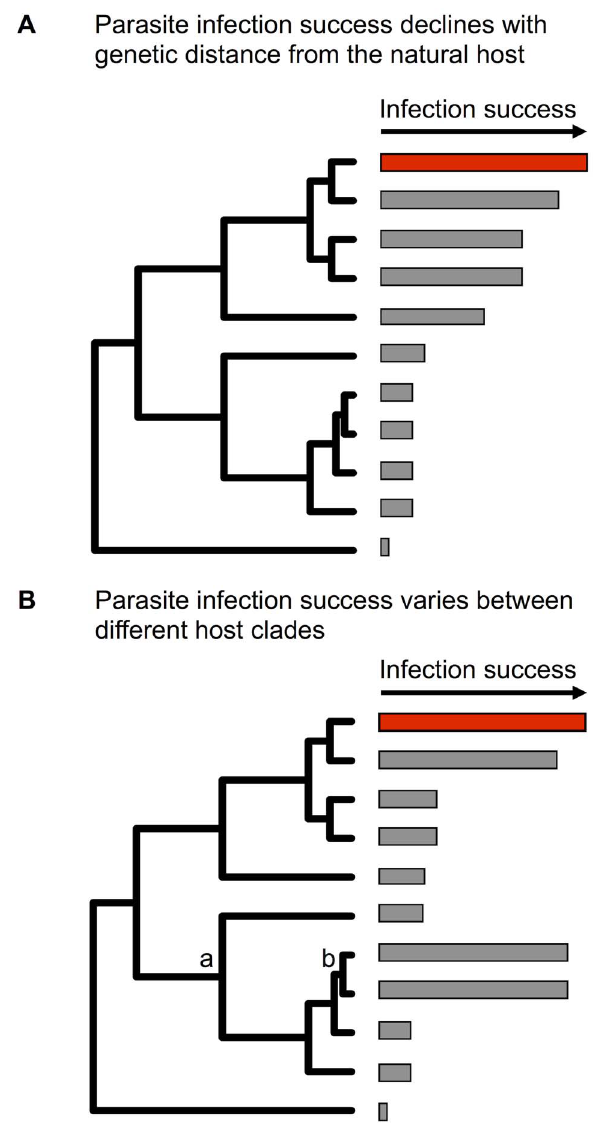
Figure 1. Two ways in which host relatedness may effect a pathogen’s ability to host shift. The bars at the tips of the trees show a measure of pathogen infection success, with the bar in red representing the pathogen’s natural host species. (A) The pathogen is less successful in host clades more distantly related to its natural host. (B) ‘‘Patches’’ of highly susceptible—or highly resistant—clades of hosts, may be scattered across the host phylogeny independently from their distance from the natural host. All of the species in the clade labelled ‘‘a’’ are equally distantly related from the pathogen’s natural host. However, the species in the clade marked ‘‘b’’ are highly susceptible, despite being distantly related to the natural host.